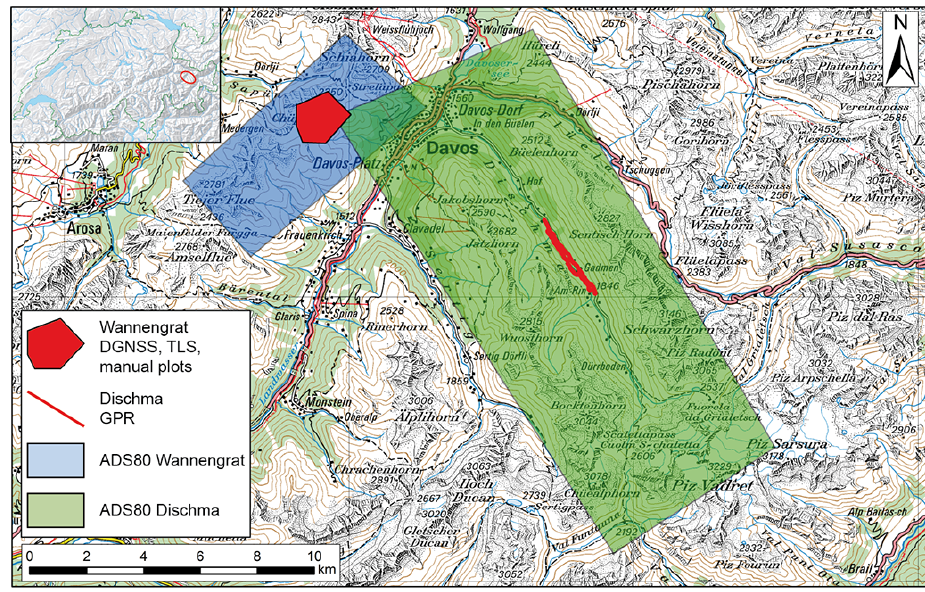
Figure 1. ADS80 data coverage and locations of the applied reference data sets at Wannengrat and in the Dischma Valley close to Davos, Switzerland. Pixmap © 2014 swisstopo